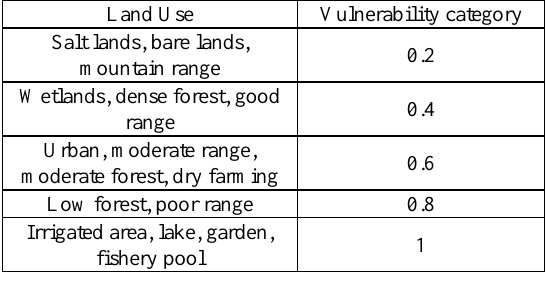
Table 6- Land Use Vulnerability Category